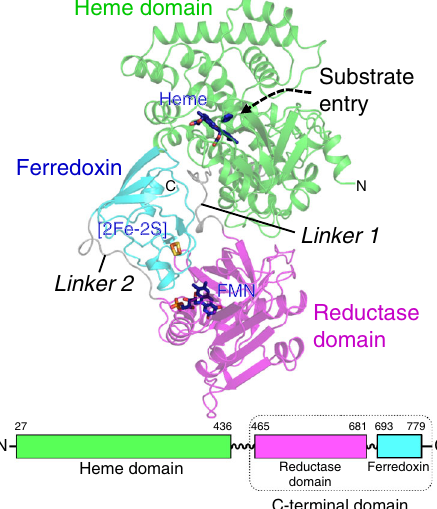
Fig. 1 Overall structure of CYP116B46. The polypeptide structure is presented as a cartoon model, with the three domains and connecting linkers in different colors. The heme domain, reductase domain and ferredoxin domain are colored in green, magenta and cyan. The bound ligands that are shown in stick models are labeled, and so are the N- and C- terminus. The lower panel shows the primary structure of CYP116B46 with the amino acid numbers indicated for each